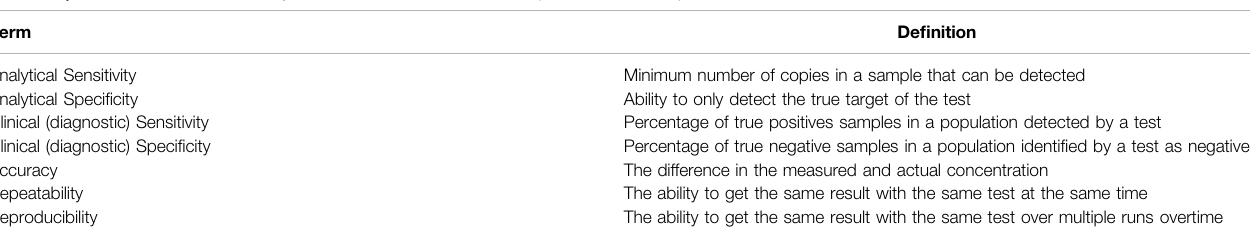
TABLE 1 | De fi nitions used in this study, based on the MIQE Guidelines (Bustin et al., 2009).